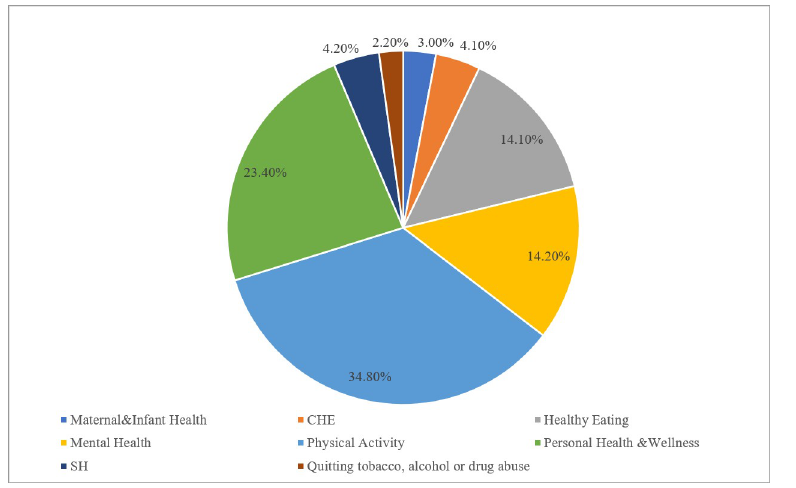
Fig 4. HECAT application